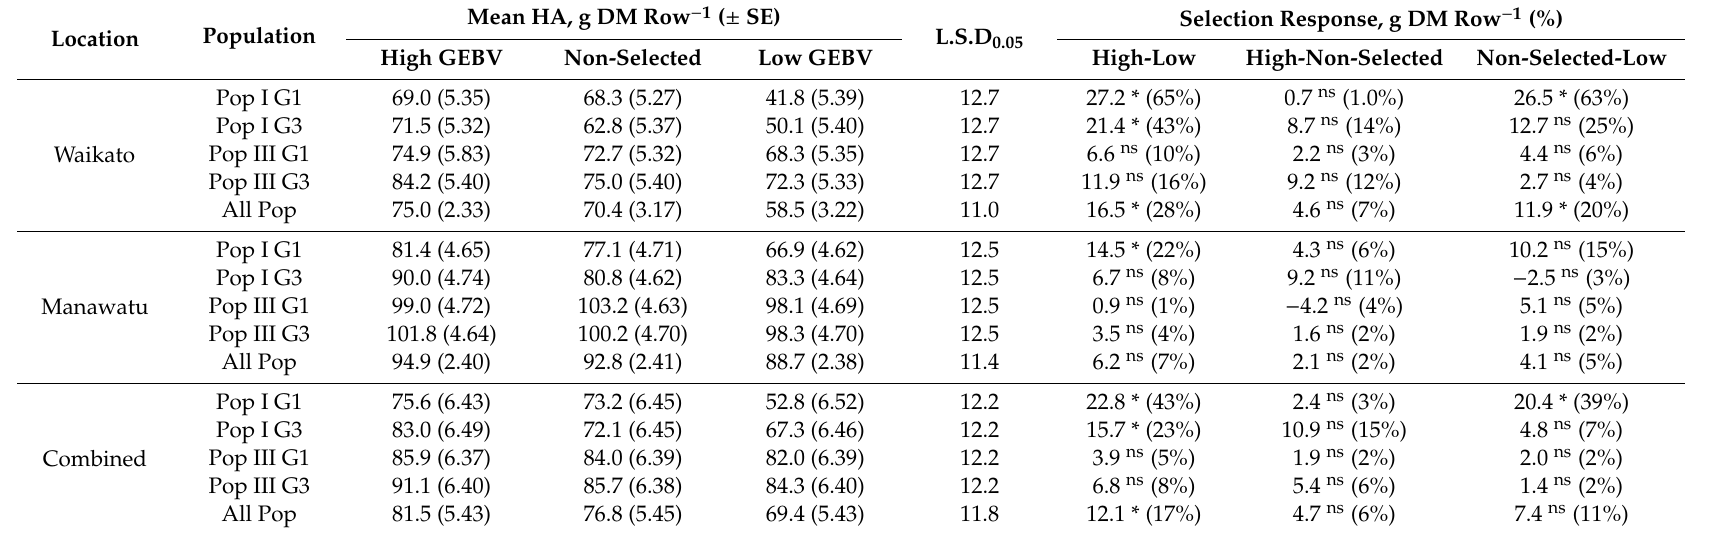
Table 2. Summary of mean herbage accumulation (HA) data for High, Low, and Non-selected selection group (SG) progenies in four populations and averaged across all four populations (All Pop). Data are BLUEs for performance in two evalaution environments (Waikato n = 7 harvests; Manawatu n = 8 harvests), as well as across both environments (combined). Under Selection Response, di ff erences between pairs of SG are: ns = not signifcant ( p > 0.05); * = significant at p <